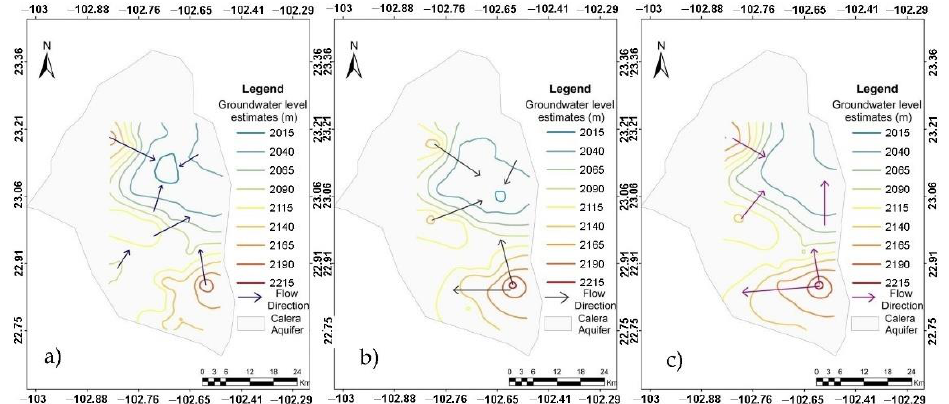
Figure 10. Groundwater-level estimations considering complete network ( a ), with the proposed method ( b ), and with the Júnez-Ferreira method ( c ). method ( b ), and with the J ú nez-Ferreira method ( c ).